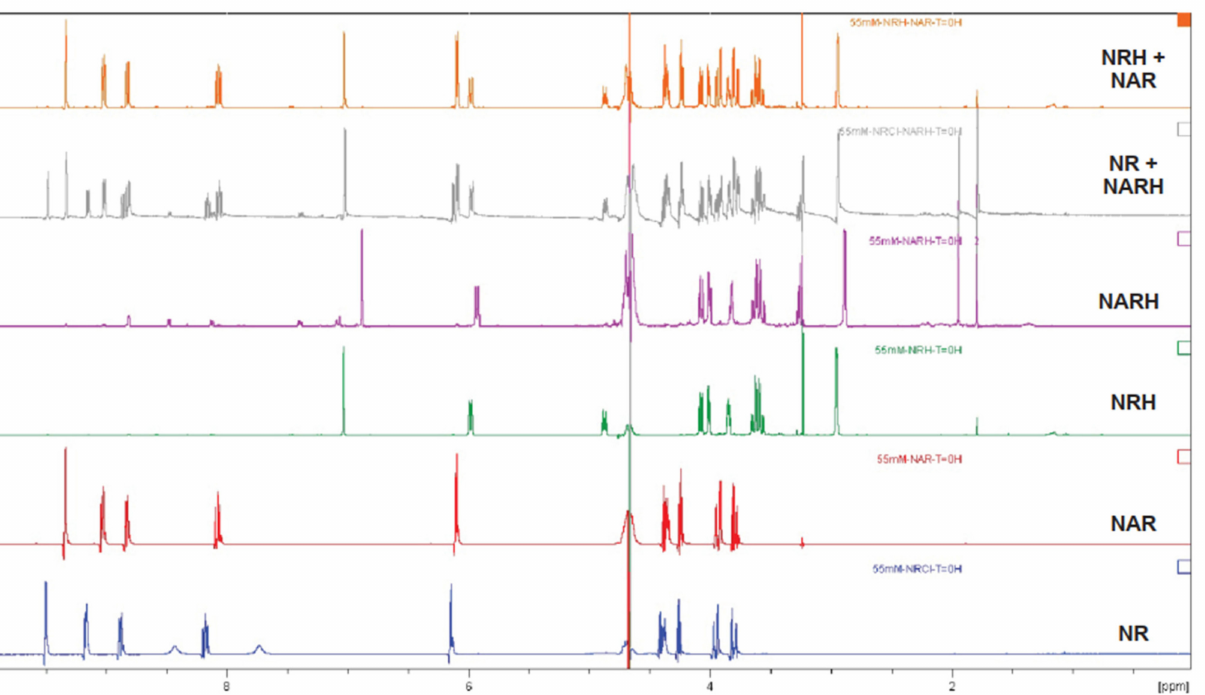
Figure 6. Transhydrogenation between NR and NARH. Proton NMR spectra of NR (NR chloride), NAR, NARH, NRH, NR+NARH and NRH+NAR in water (10% D 2